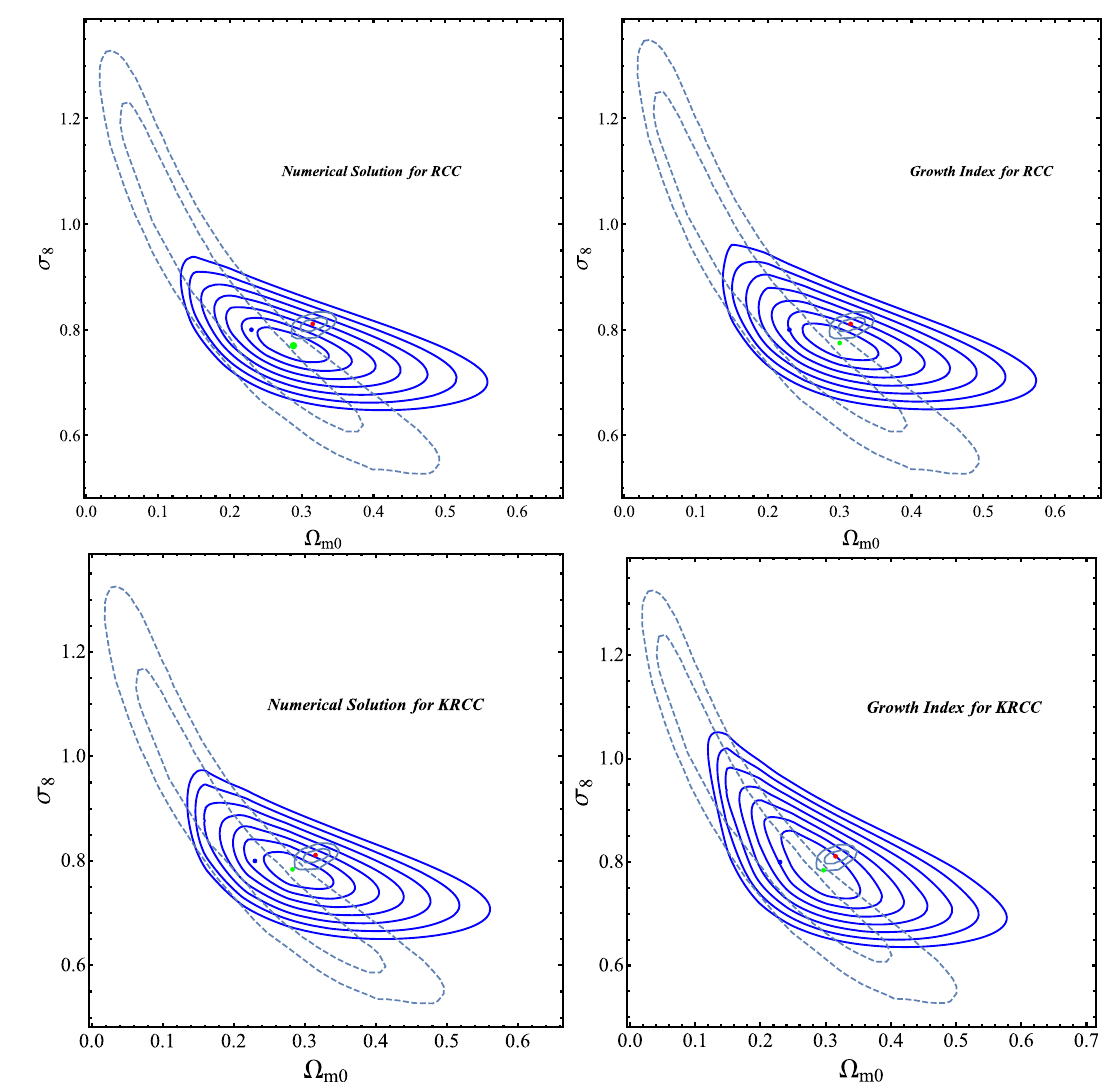
Fig. 3 In the top, we can see observational constraints on the flat RCC model. In the bottom, we see the observational constraints on the non-flat RCC model. The (cid:3) k 0 parameter was marginalized in the range of − 0 . 1 < (cid:3) k 0 < 0 .